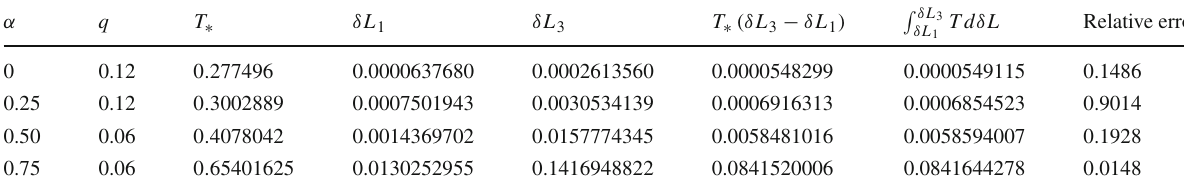
Fig. 6 F vs. T for n = 4 , l = 1 , b = 1 , k = 1. a α = 0 , q = 0 . 12, b α = 0 . 25 , q = 0 . 12, c α = 0 . 50 , q = 0 . 06, d α = 0 . 75 , q = 0 .